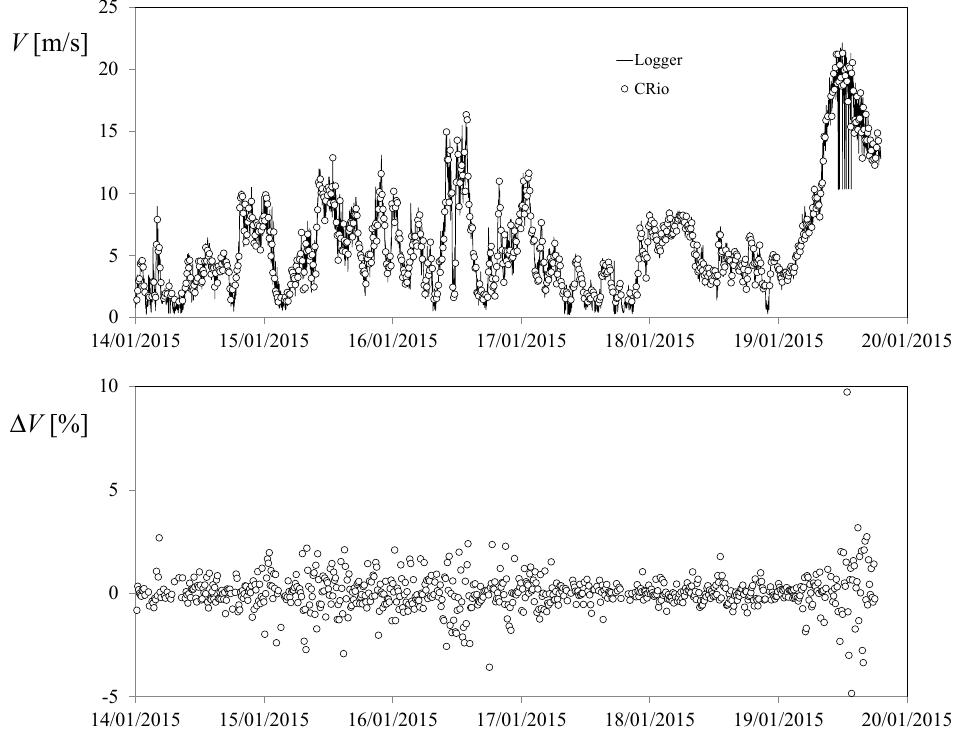
Figure 2. Comparison between the wind speed measured by the CompactRIO system and the Kintech data logger, both connected to the Anemometer 2 output. In the bottom graph, the percentage variation of the CompactRIO measurements in relation to the data logger are plotted.